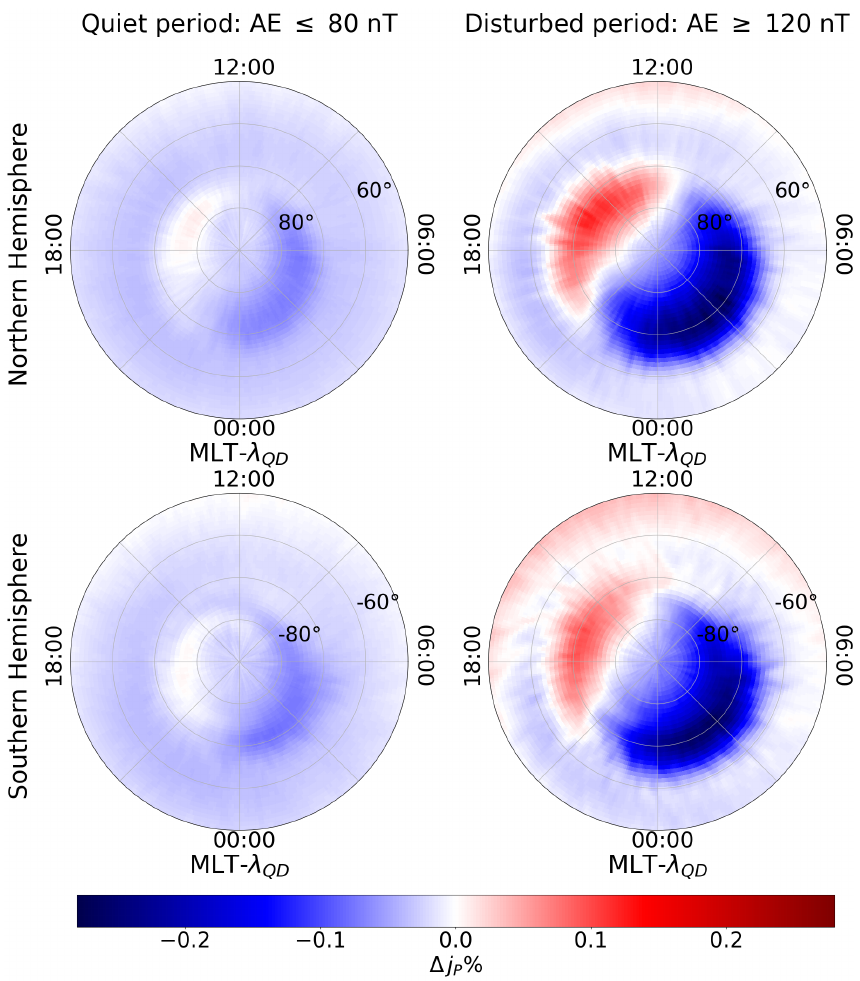
Figure 6. Difference in percentage between the pressure-gradient current evaluated using the mag- netic field measured by Swarm A and that evaluated using the magnetic field of internal origin, in the case of quiet ( left column) and disturbed ( right column) geomagnetic activity conditions, for the Northern and Southern hemispheres, in QD-latitude ( λ QD > 50 ◦ and λ QD < − 50 ◦ for the Northern and Southern hemisphere, respectively) and MLT reference